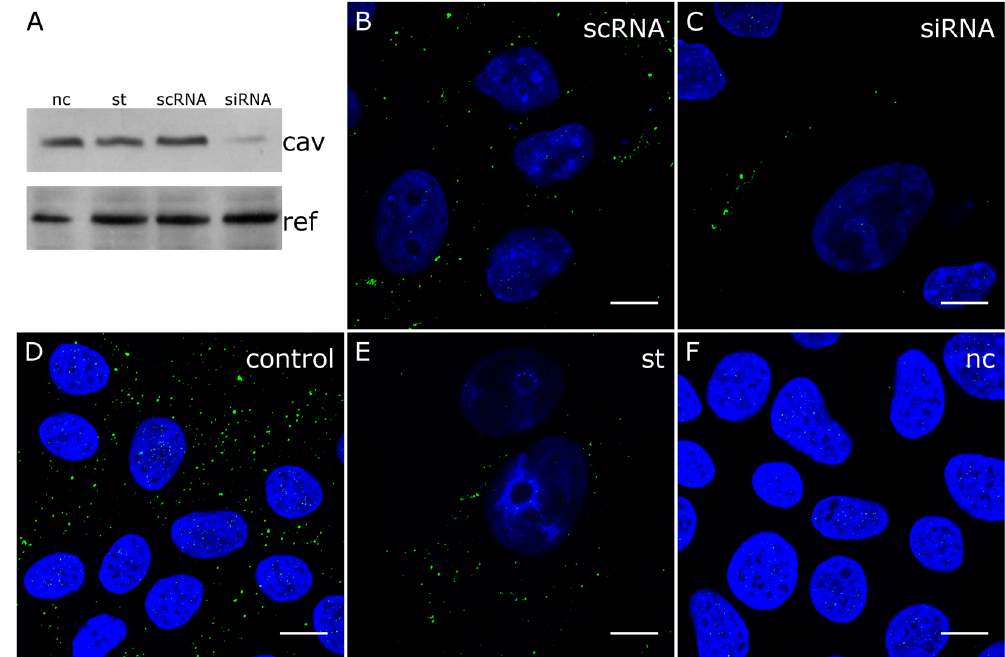
Figure 5. Inhibition of HCoV-OC43 entry to the caveolin-1 depleted cells. ( A ) Western blot analysis of the efficiency of siRNA-dependent caveolin-1 silencing (caveolin-1 expression in HCT-8 cells compared to β -tubulin expression in these cells). Confocal analysis of HCoV-OC43 localization 1 h p.i. in HCT-8 cells. scRNA ( B ) HCoV-OC43-infected, scrambled siRNA transfected cells; siRNA ( C ) HCoV-OC43-infected, caveolin-1-specific siRNA transfected cells; control ( D ) HCoV-OC43-infected, non-transfected cells; st ( E ) HCoV-OC43-infected, sham-transfected cells; nc ( F ) mock-infected, non-transfected cells. HCoV-OC43 is visualized in green and nuclei are shown in blue. Scale bar = 10 μ m. The experiment was conducted at least twice, and representative images are presented.